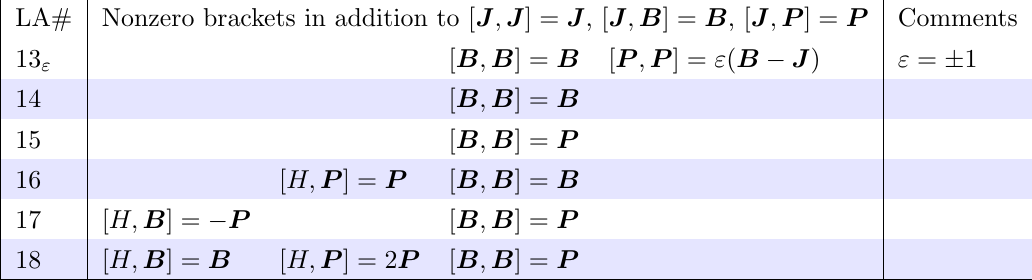
Table 6 . Kinematical Lie algebras unique to D =